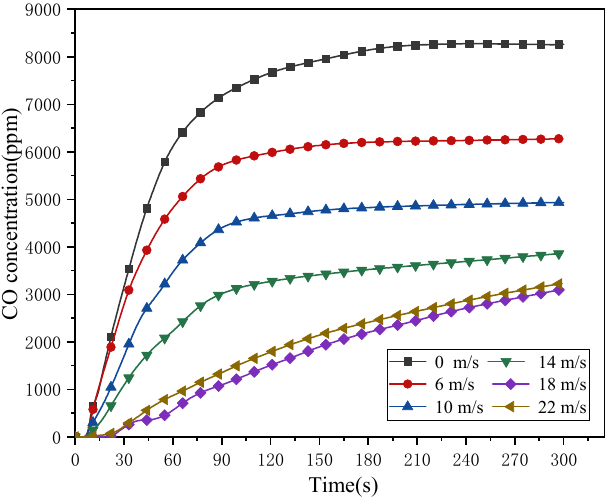
Figure 9. The CO concentration with air curtains installed on the left side.